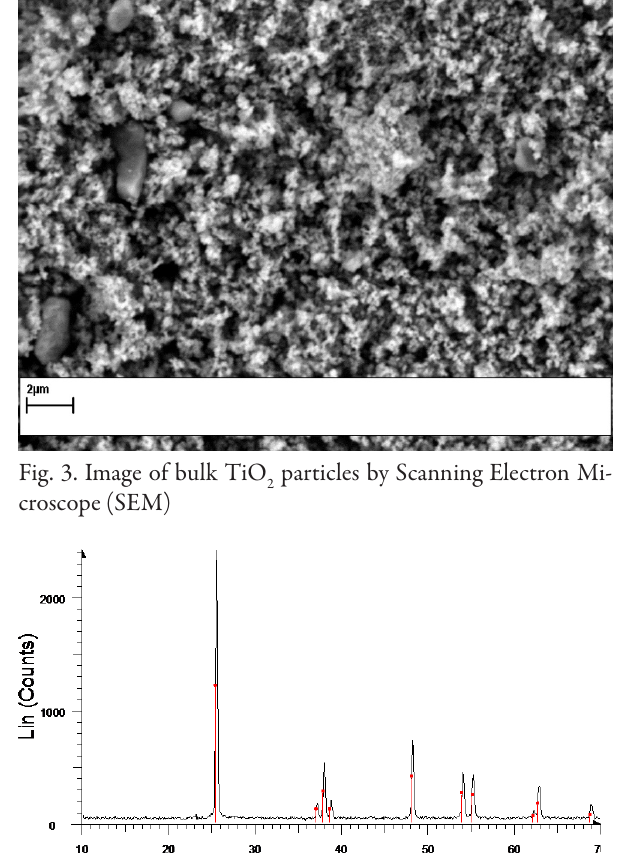
Fig. 4. X-ray diffraction (XRD) pattern of bulk TiO